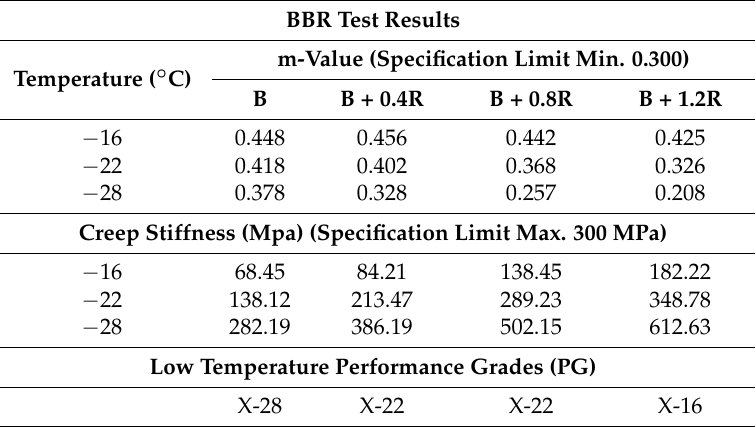
Table 7. BBR test results of all